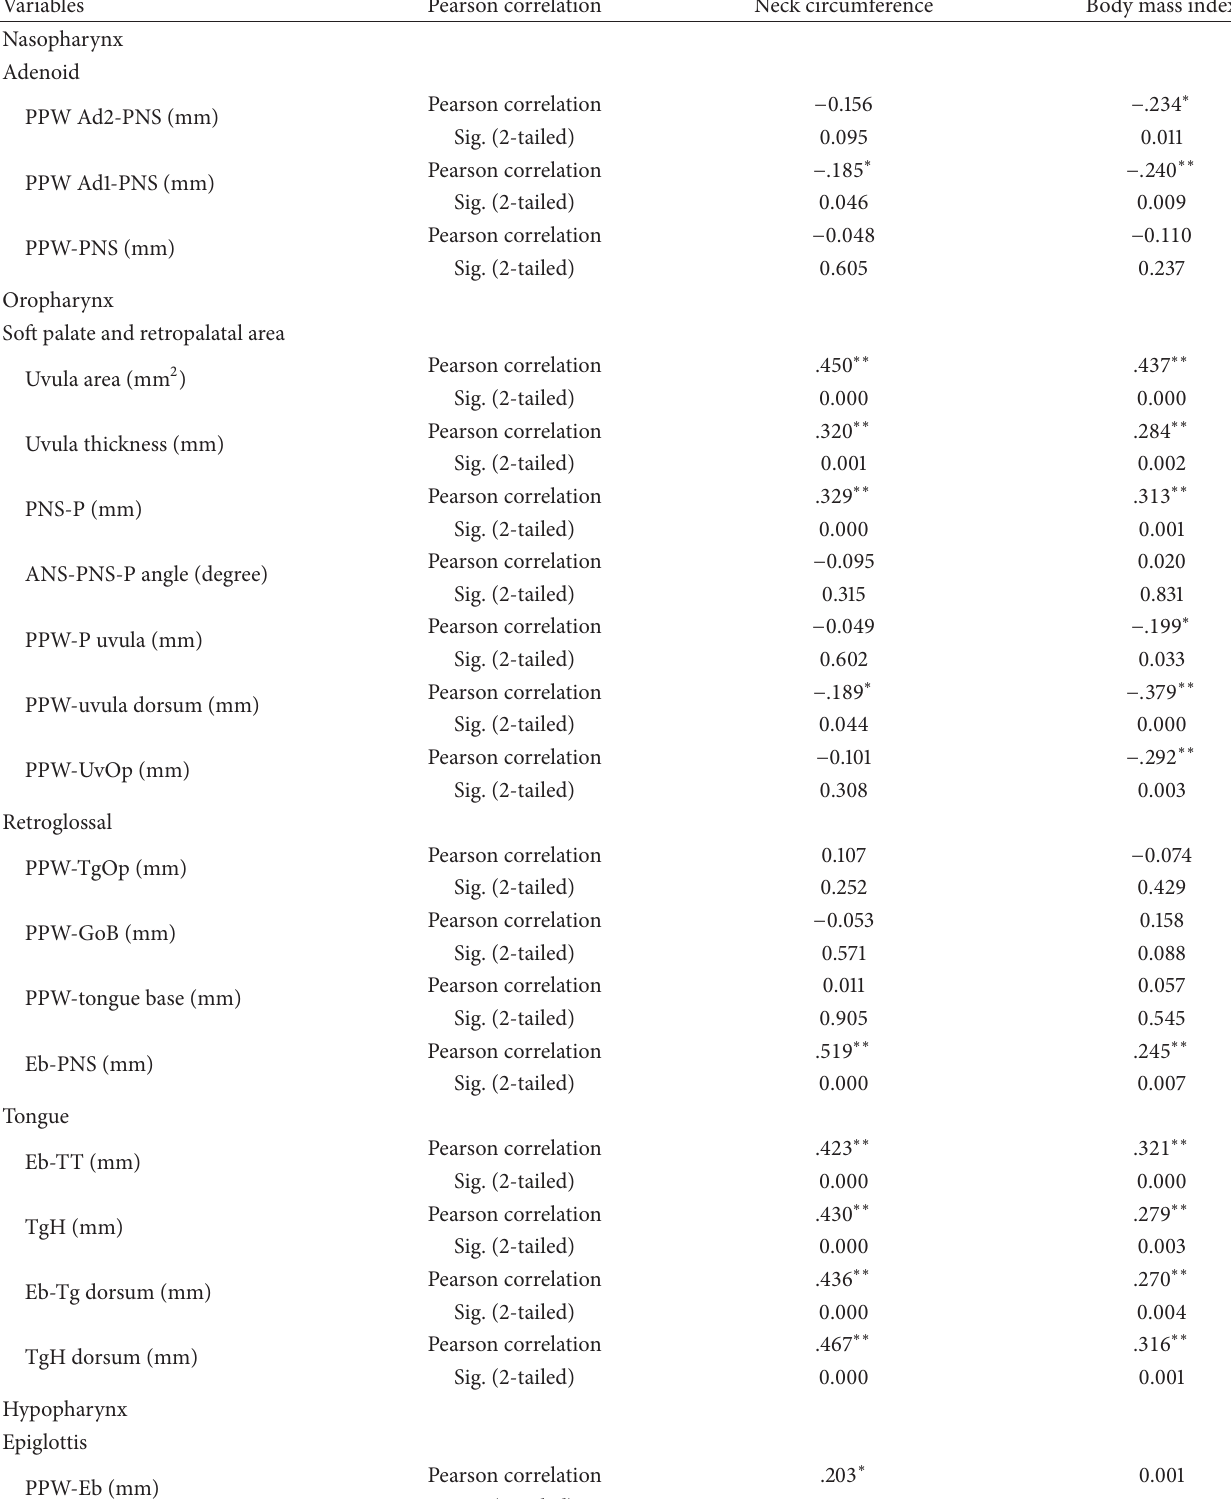
Table 5: Correlation between anthropometric and airway variables. ∗ Correlation is significant at the 0.05 level (2-tailed). ∗∗ Correlation is significant at the 0.01 level